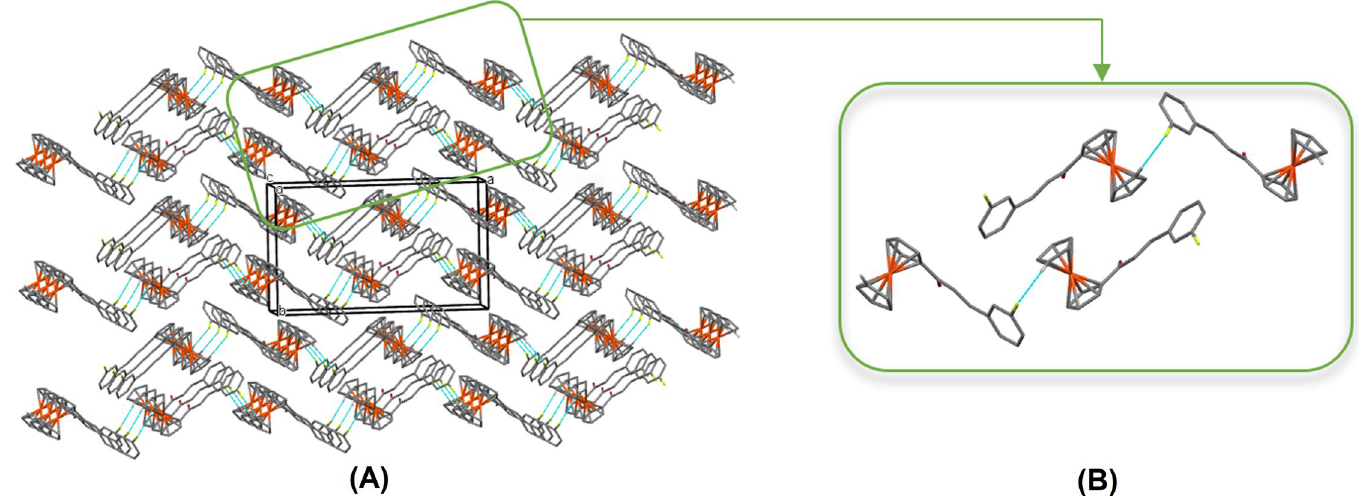
Fig 5. Crystal packing of Fc1. (A) Full view within a unit cell. (B) A partial view along the a -axis of the crystal packing. The C—H ��� F hydrogen bonds are shown as cyan dashed